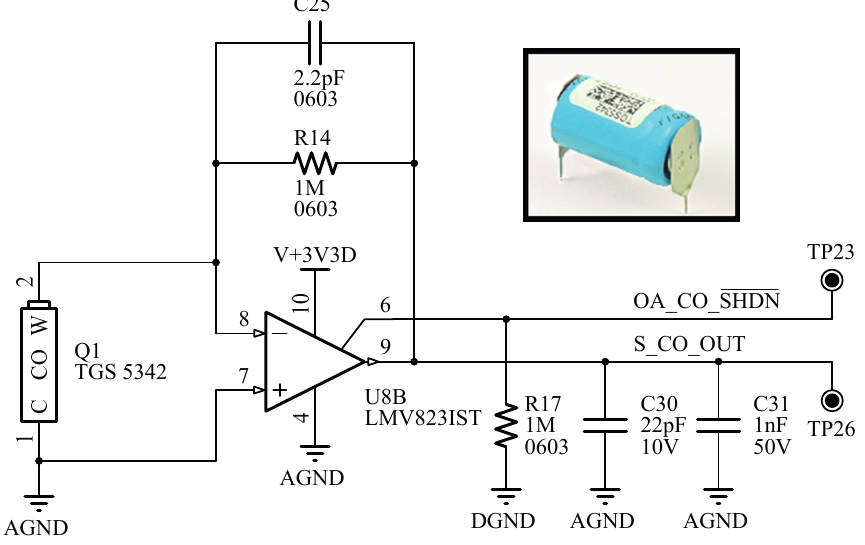
Figure 4. Scheme of the CO